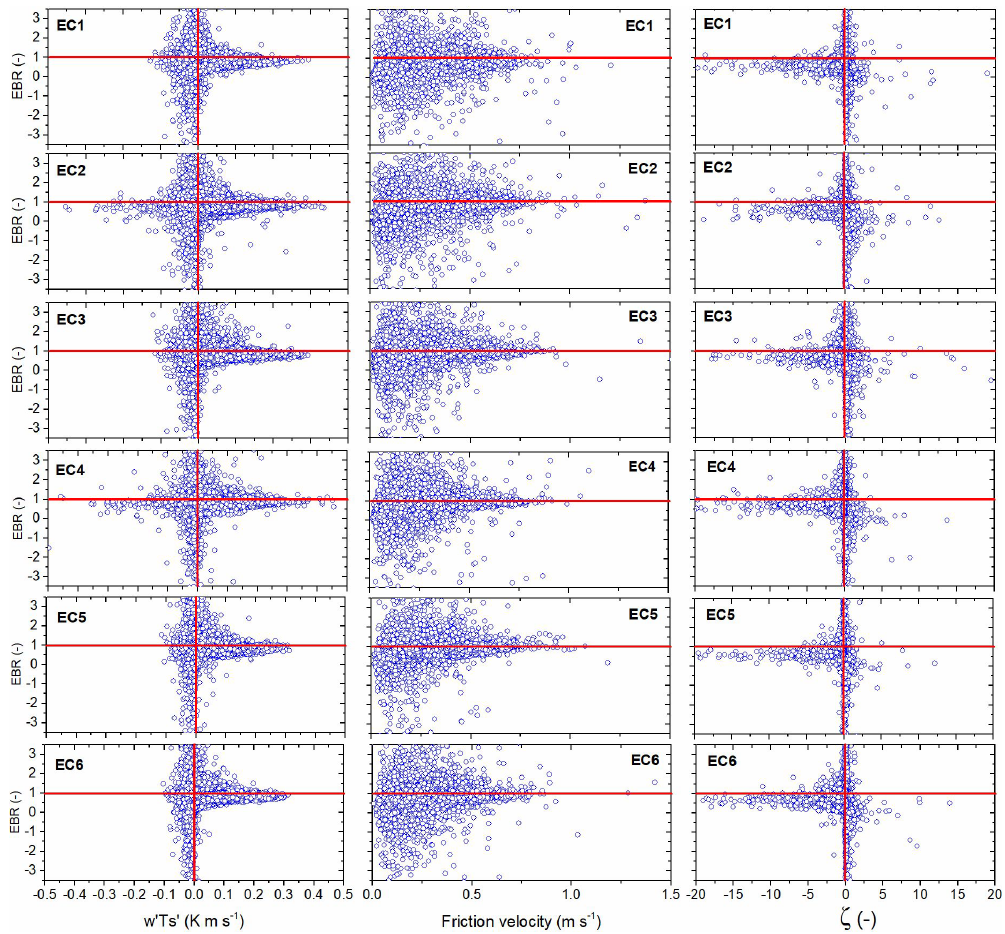
Figure 10. The mean energy balance ratio (EBR) as a function of buoyancy flux ( w (cid:48) T (cid:48) s ) , friction velocity ( u ∗ ), and the stability parameter ( ζ ) during the 2010–2017 study period.